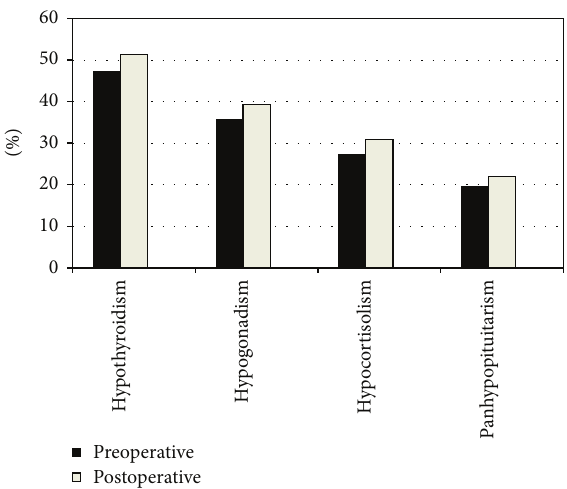
Figure 1: Prevalence of pituitary hormone deficiencies before and after surgery.